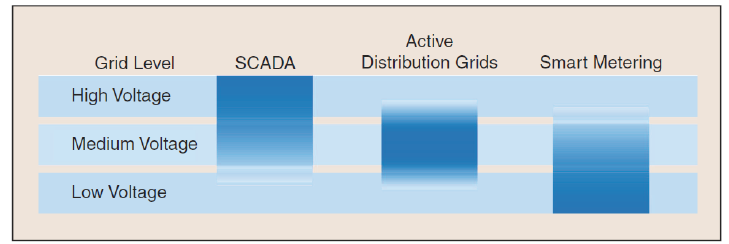
Figure 2. Major ICT application domains in smart grids and their correlation with the grid levels. SCADA, supervisory control and data